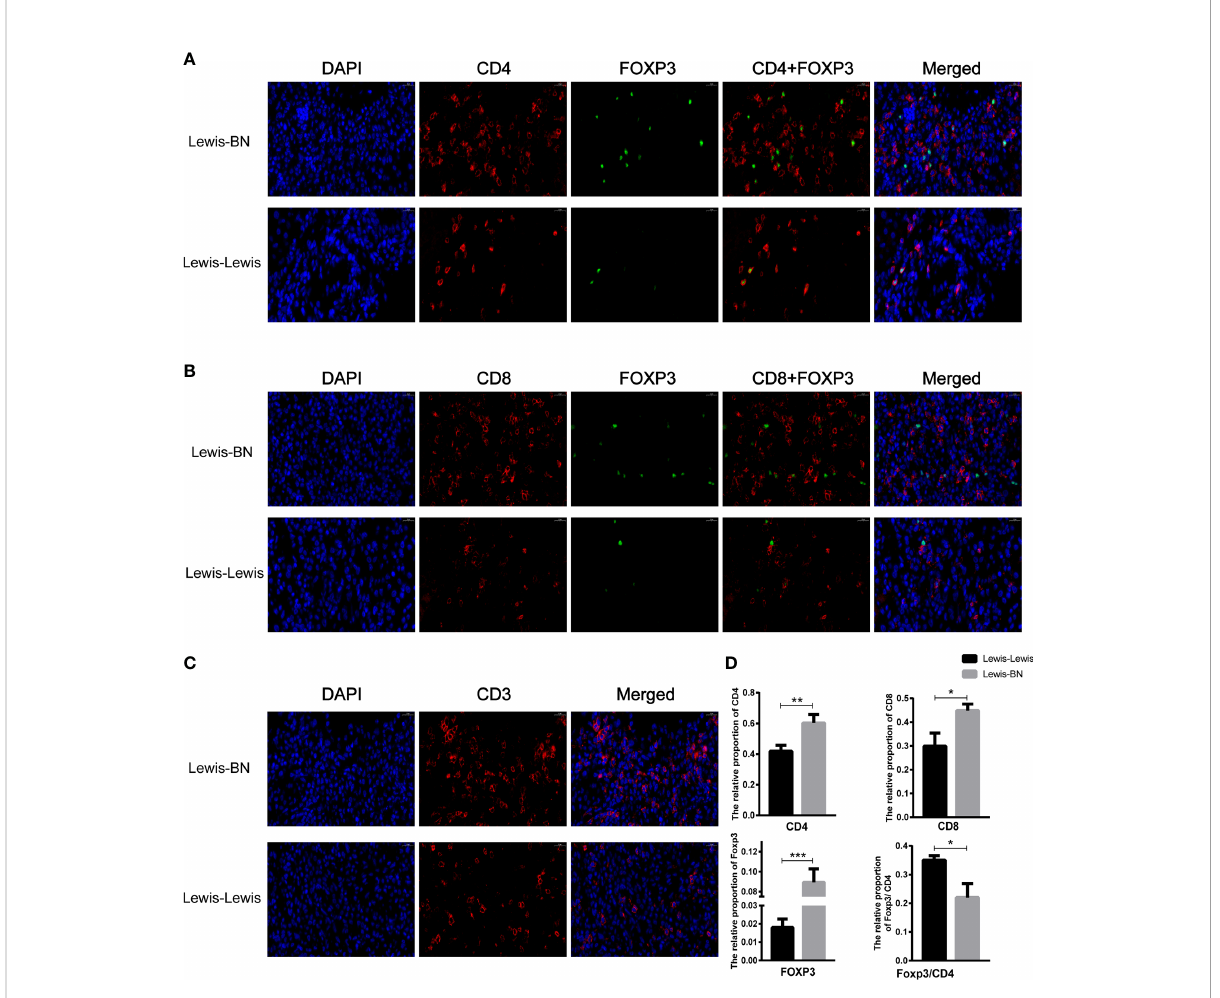
FIGURE 5 Comparison of the content of cells in fi ltrating graft between two groups. (A-D) The cells in fi ltrating the graft were examined by immuno fl uorescence staining. *P<0.05, **P < 0.01, ***P <